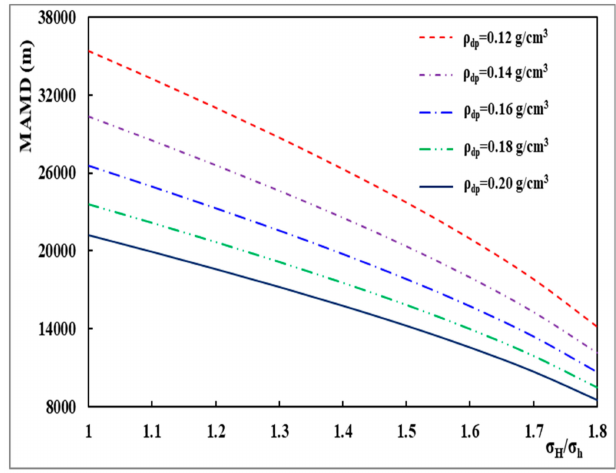
Figure 14. Effect of σ H / σ h on the MAMD.